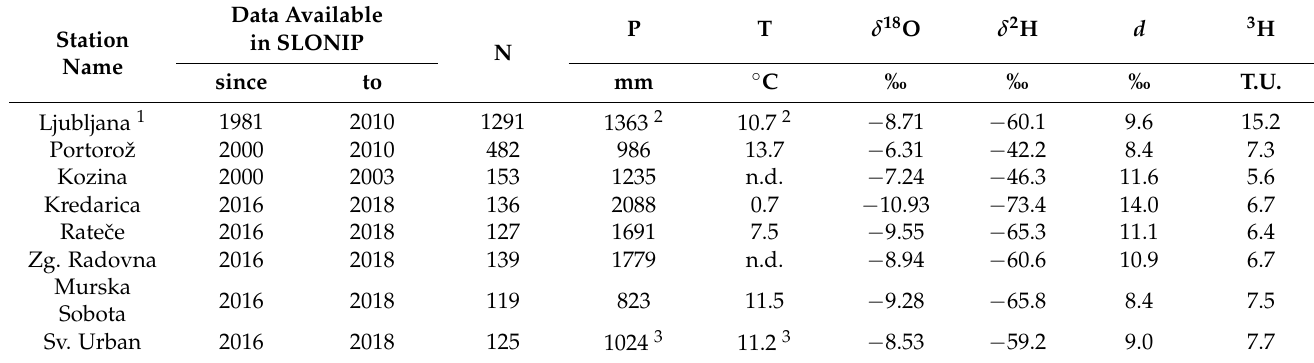
Table 3. Available data in SLONIP: long-term means of precipitation amount (P), air temperature (T), the isotopic composition of oxygen ( δ 18 O), the isotopic composition of hydrogen ( δ 2 H), deuterium excess ( d ) and activity concentration of tritium ( 3 H). N—number of all isotope data in SLONIP; n.d.—not